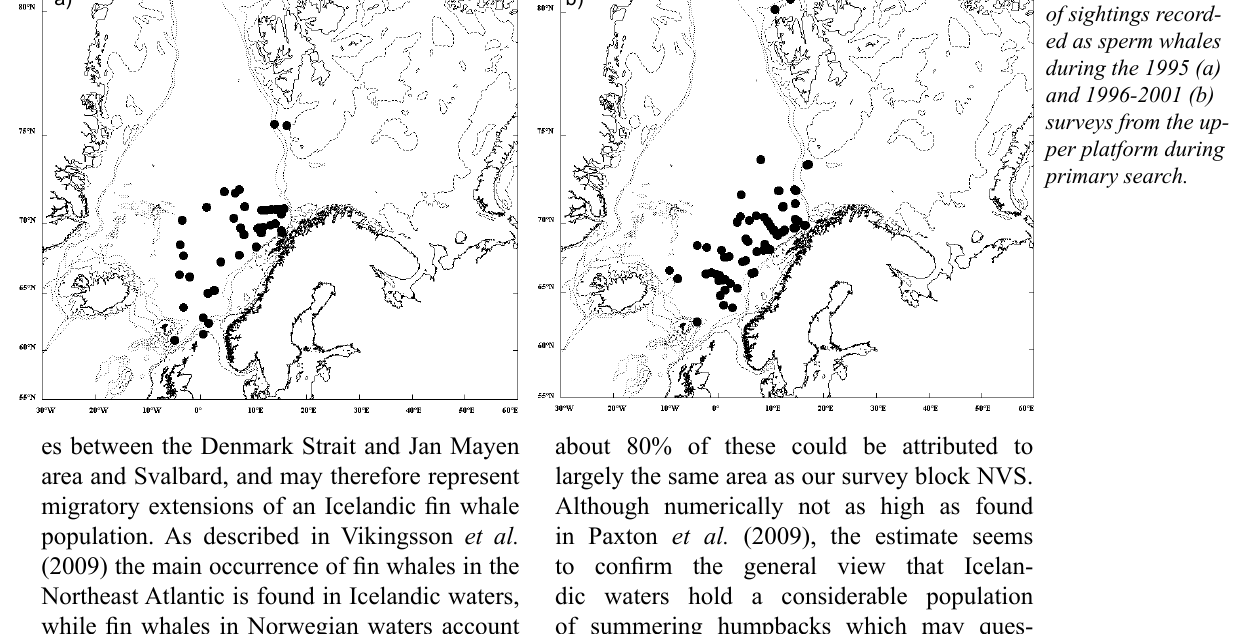
of sightings record- ed as sperm whales during the 1995 (a) and 1996-2001 (b) surveys from the up - per platform during primary